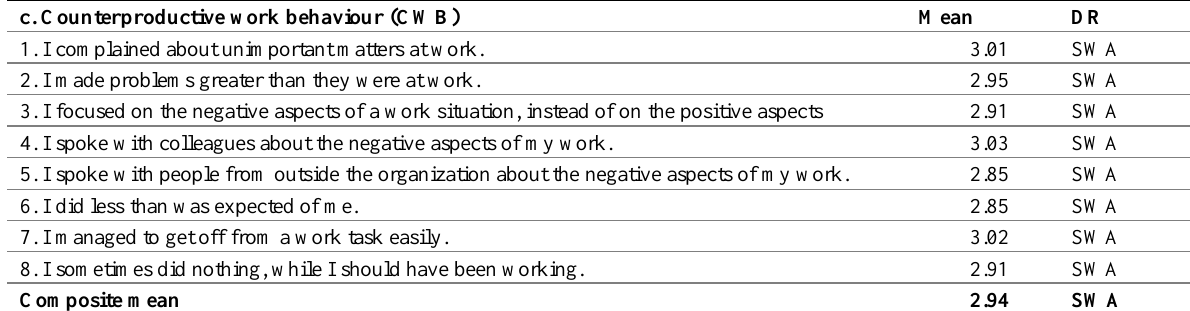
Table 5: Individual Work Performance as to Counterproductive Work